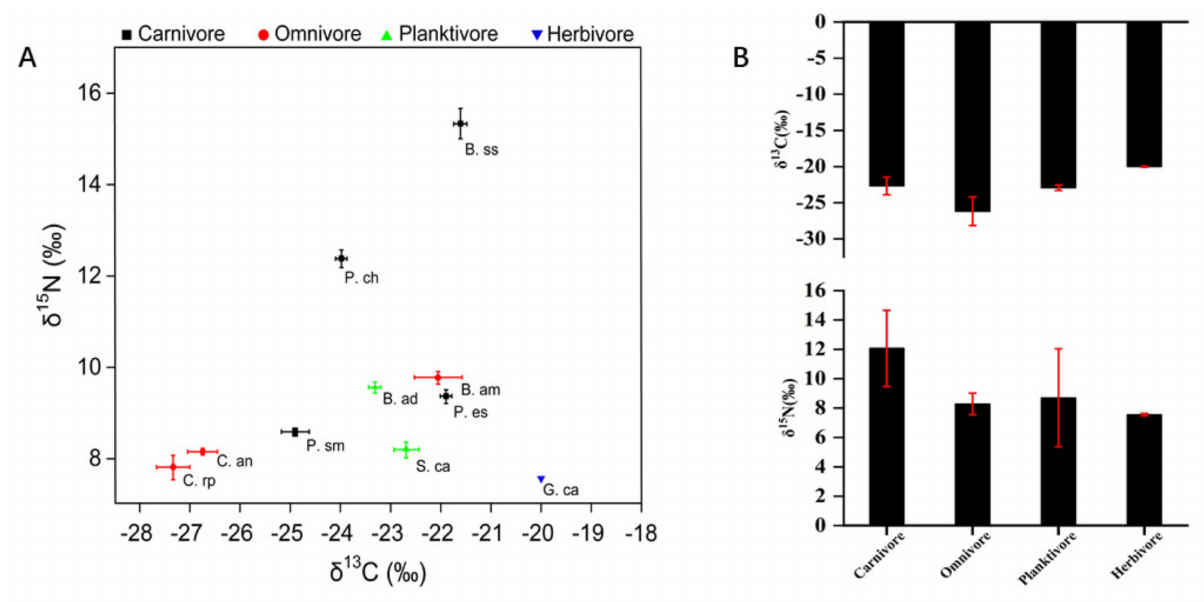
Figure 4. Food web structure ( A ); The comparison of carbon and nitrogen values of fish with varying diets ( B